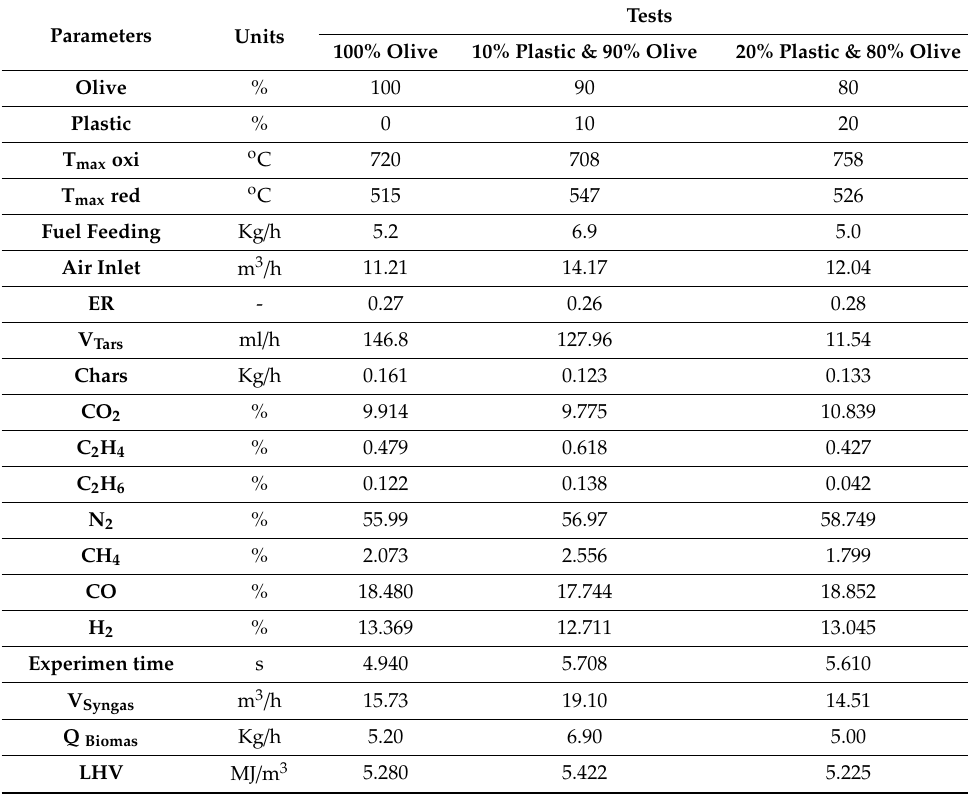
Table 9. Gasification tests of plastics and olive biomass